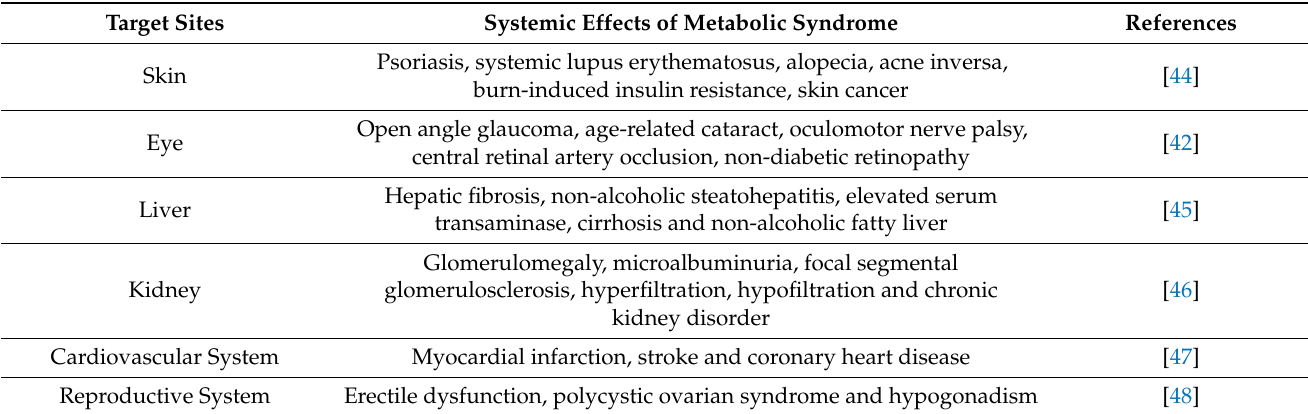
Table 1. Adverse effects of metabolic syndrome on different body